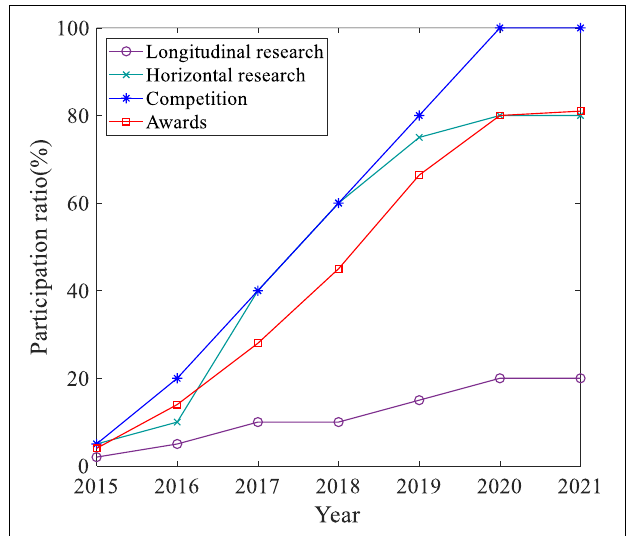
FIGURE 8 | Competition and scientific research